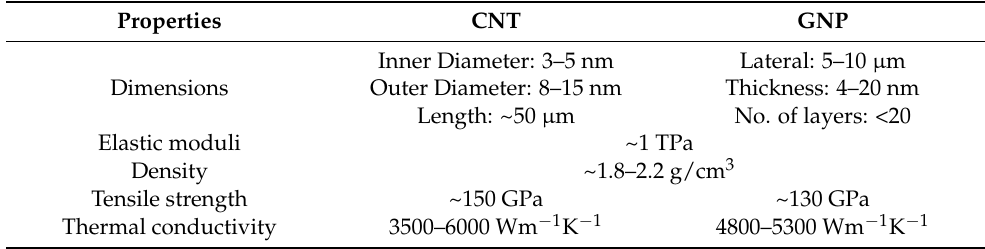
Table 1. Properties of Carbon nanotubes (CNT) and Graphene nanoplatelets (GNPs)